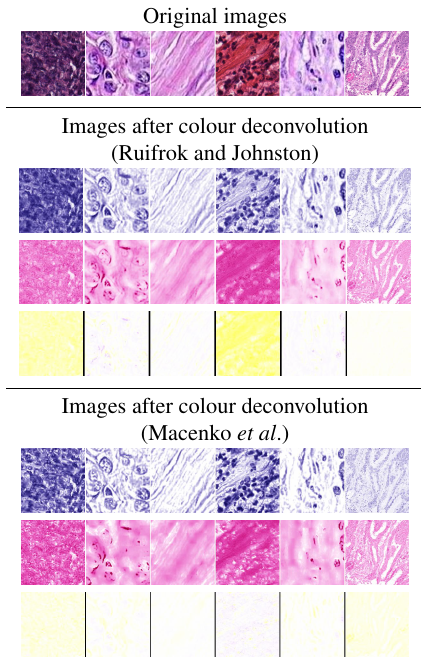
Figure 3. Effects of colour deconvolution through Ruifrok and Johnston’s [26], and Macenko et al.’s method [25]. The top row shows the original images, then each box below reports the deconvolved haematoxylin channel (first row), the deconvolved eosin channel (second row) and the background channel (third row). The haematoxylin, eosin and background channels are rendered in